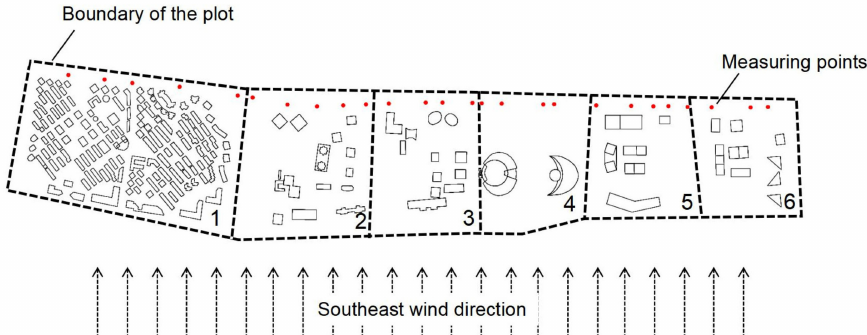
Figure 12. The subdivision plots with the corresponding measuring points.